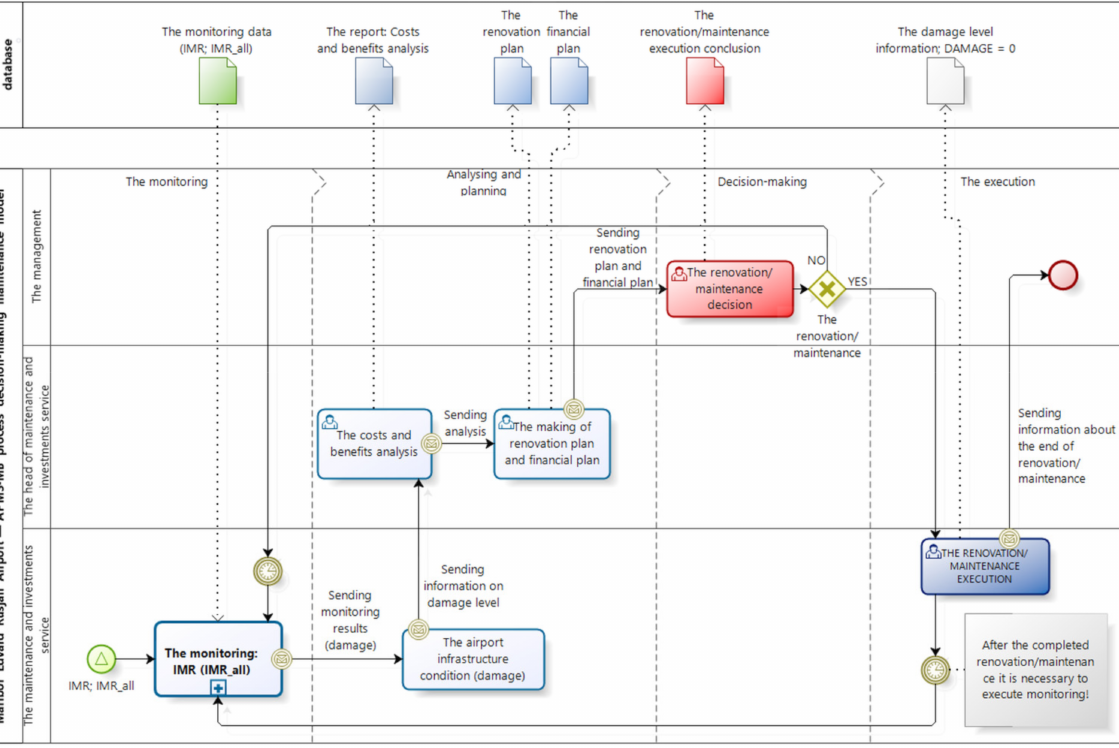
Figure 5. BPD of the process decision-making maintenance model